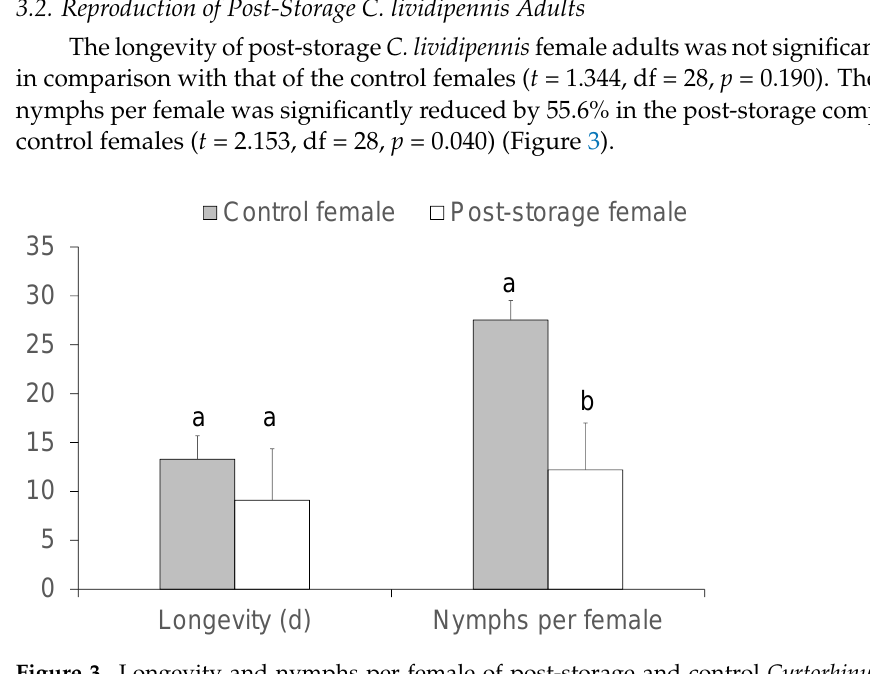
Figure 3. Longevity and nymphs per female of post-storage and control Cyrtorhinus lividipennis female adults. The data represent mean ± SE. Different letters over the bars indicate significant differences (independent sample t -test, p = 0.05).